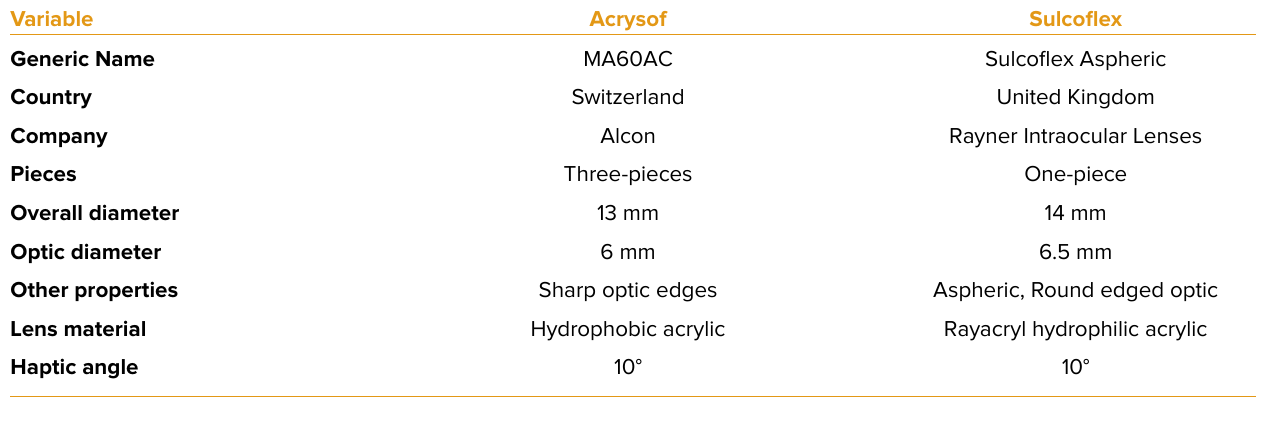
Table 2. Patients demographic